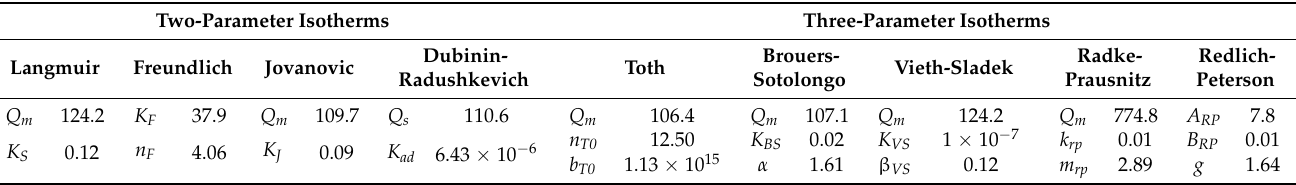
Table 2. Calculated parameters of the adsorption isotherms.